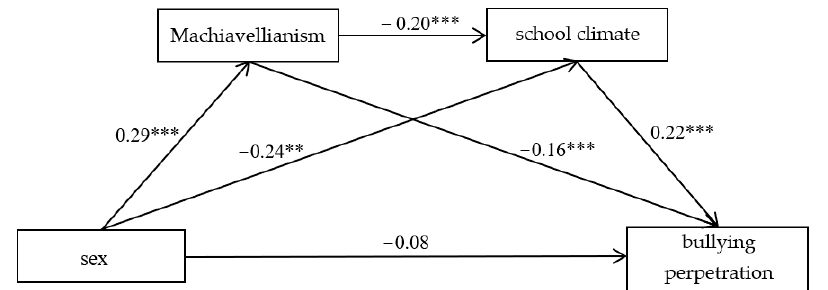
Figure 2. The chain-mediating effect of Machiavellianism and school climate between sex and bullying perpetration. Note: ** p < 0.01, *** p <